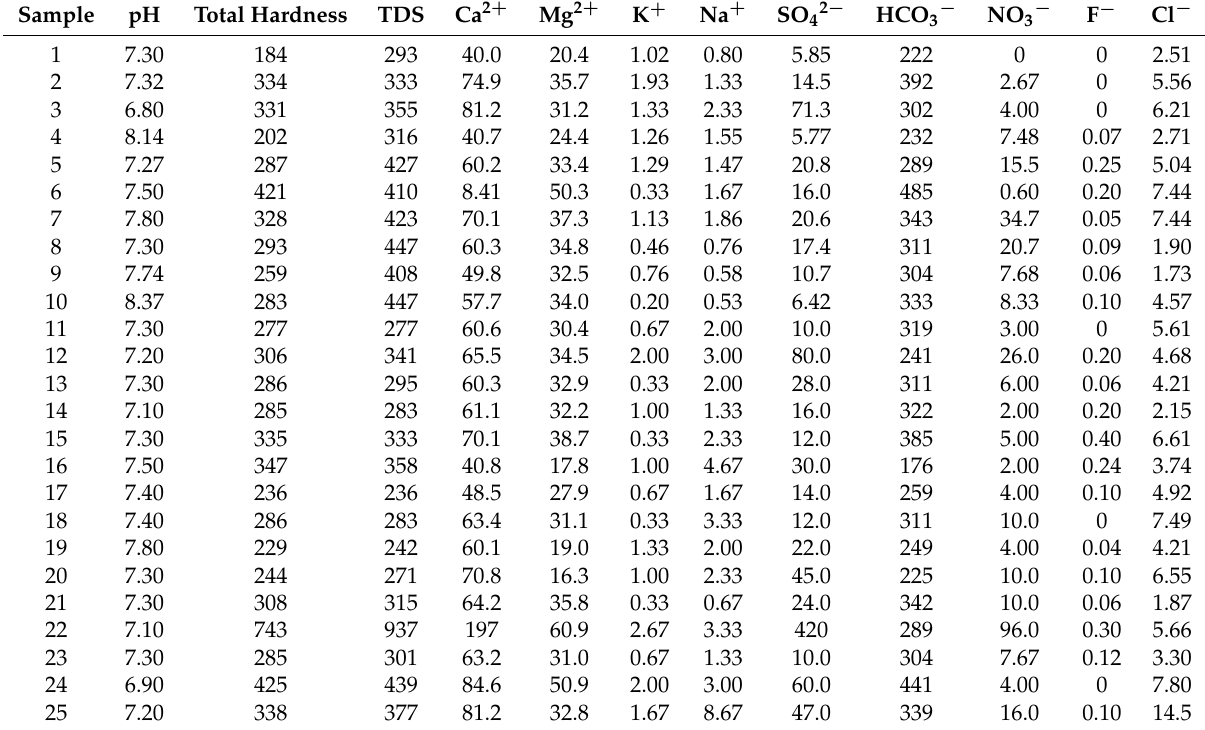
Table 1. Geochemical concentrations in groundwater samples collected from the studied dolomite aquifer between 2008 and 2012 (all concentrations in mg/L), including the pH, total hardness, total dissolved solids (TDS), cations (K + , Na + , Ca 2 + , Mg 2 + ), and anions (HCO 3 − , F − , Cl − , NO 3 − , SO 42 −